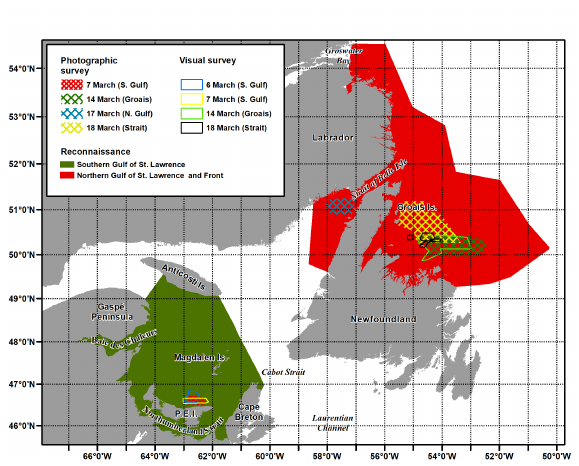
Figure 1. Reconnaissance and locations of whelping concentrations identified during the 2017 Harp Seal survey. coastal edge of the ice pack, to the seaward edge between 49°30’N and 55°00'N at the Front and between the Strait of Belle Isle (~51°50'N) and the southern edge of the ice at approximately 49°45’N in the northern